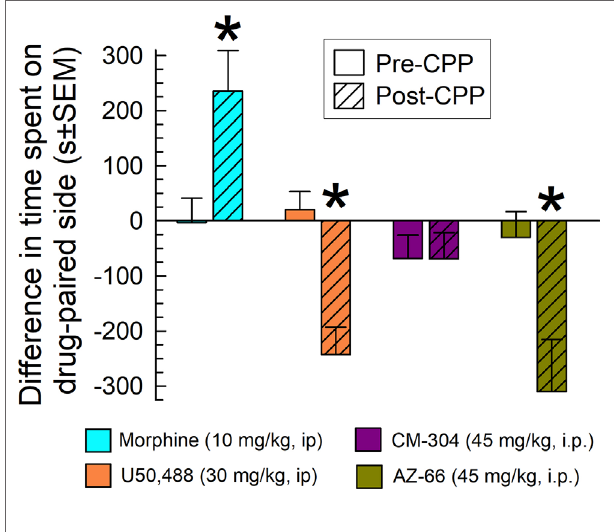
FIGURE 11 | CM-304 (45 mg/kg/d, i.p.; N = 34) did not demonstrate place- conditioning preference (as did morphine, N = 17) or aversion, whereas AZ-66 (45 mg/kg/d, i.p., N = 19) demonstrated CPA similar to U50,488 (N = 28) in the mouse conditioned place preference assay. * = post-conditioning response (striped bars) significantly different from matching pre-CPP response (matching open bars), p < 0.05; two-way ANOVA w/Sidak’s post hoc